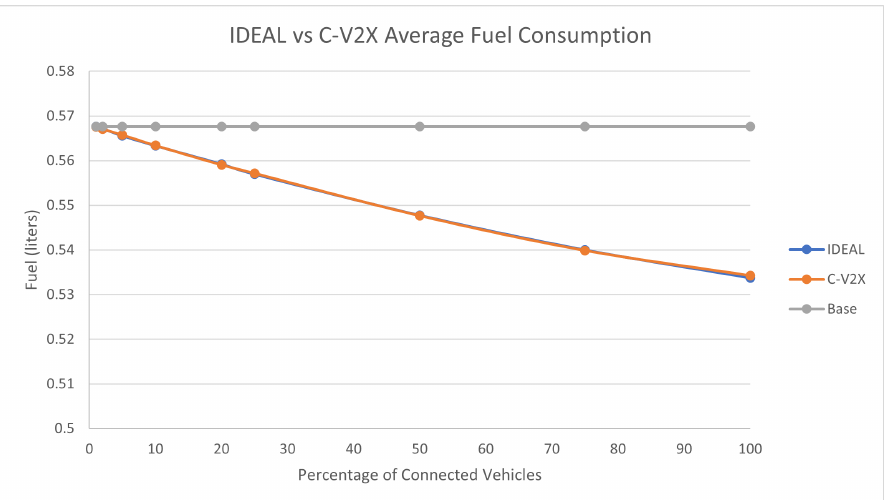
Figure 13. Average network-wide Fuel consumption of Energy-Efficient dynamic routing application using IDEAL and C-V2X communication on LA road network with traffic demand of scale factor